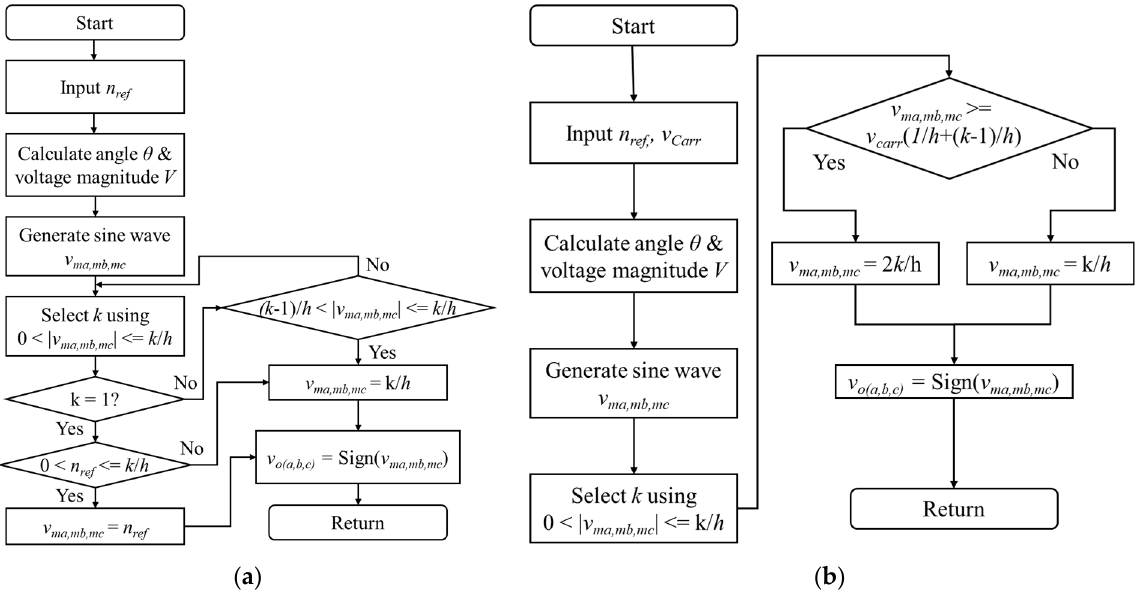
Figure 2. Comparison of switching operation flow charts. ( a ) Conventional model; ( b ) proposed